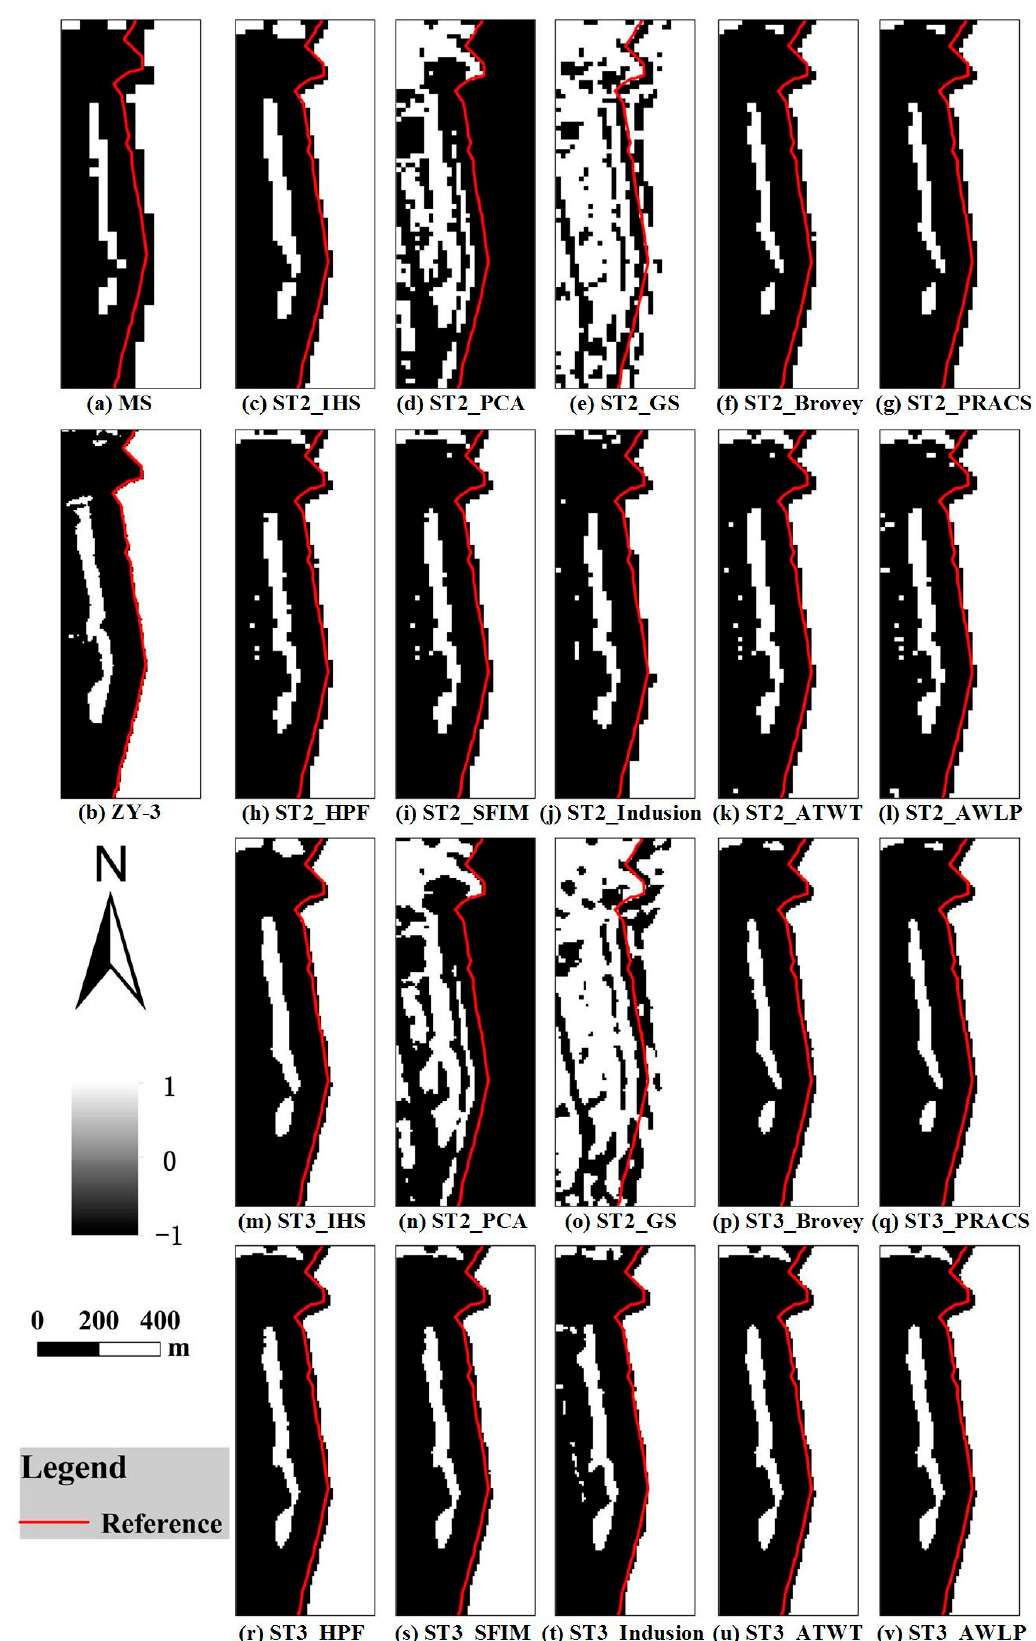
Figure 5. Classified water and non-water binary sub-maps using Otsu Figure 5 . Classified water and non-water binary sub-maps using Otsu method.